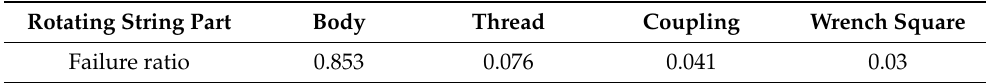
Table 3 indicates that the majority of rod failures occur across the bodies. Table 3. Rotating string failure across structural elements. Rotating String